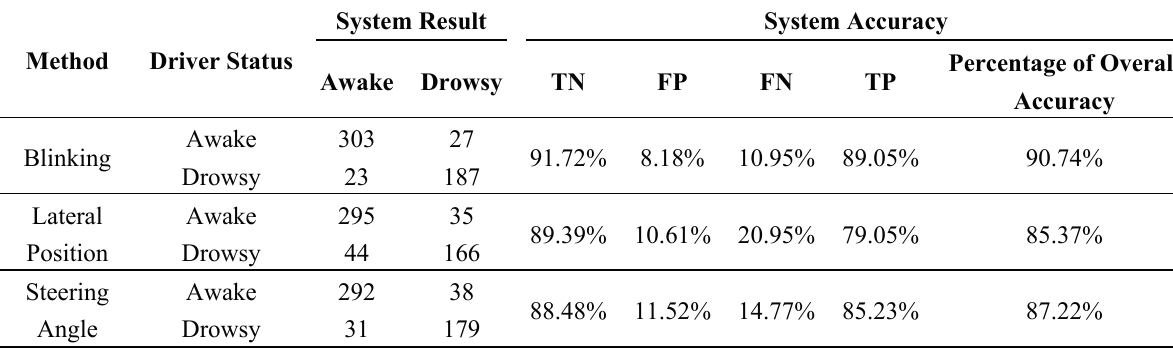
Table 3. Performance of each method in drowsiness